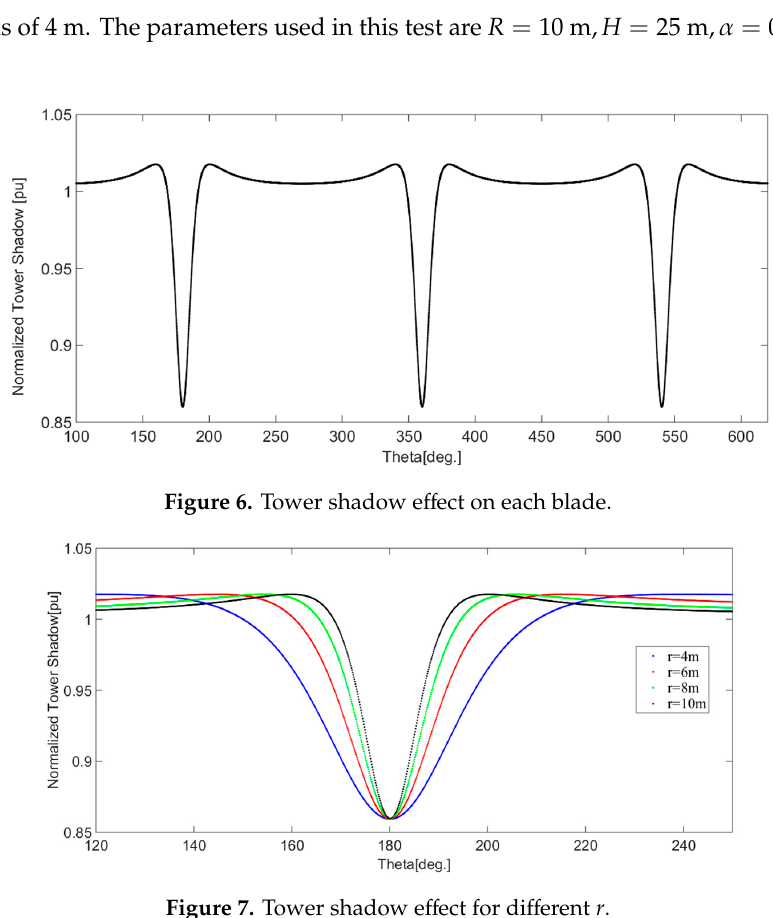
Figure 7. Tower shadow effect for different r .